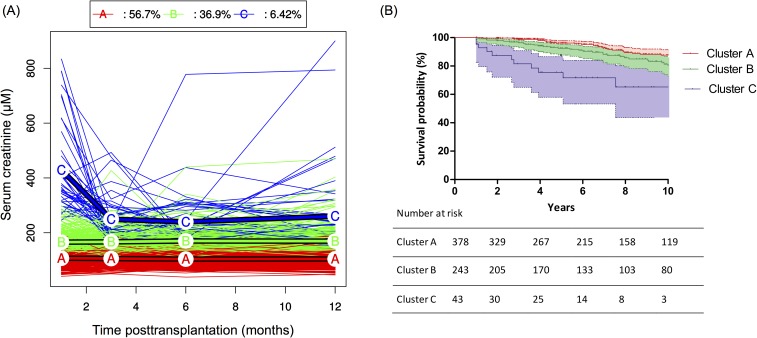
Serum creatinine clusters.(A) Mean trajectories of serum creatinine resulting from k-means for the longitudinal data clustering method superposed with individual profiles over the first 12 months post-transplantation. (B) Kaplan-Meier estimates (±95% confidence intervals) of graft survival according to the first-year creatinine profile cluster. The free graft failure survival was significantly associated with clusters (log-rank test, p<0.0001).